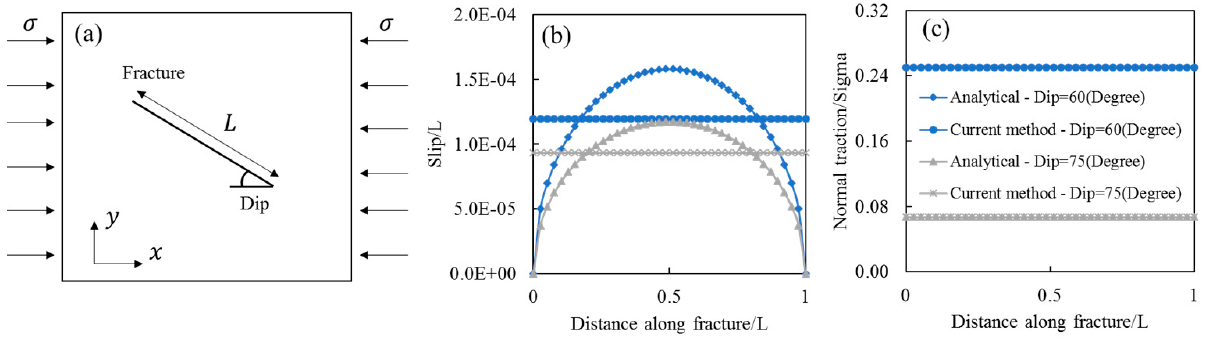
Figure A3. Frictional slip of a single fracture: ( a ) shows the boundary conditions and fracture geometry in numerical model; ( b ) is the dimensionless slip distance along the fracture; ( c ) is the dimensionless normal traction along the fracture.